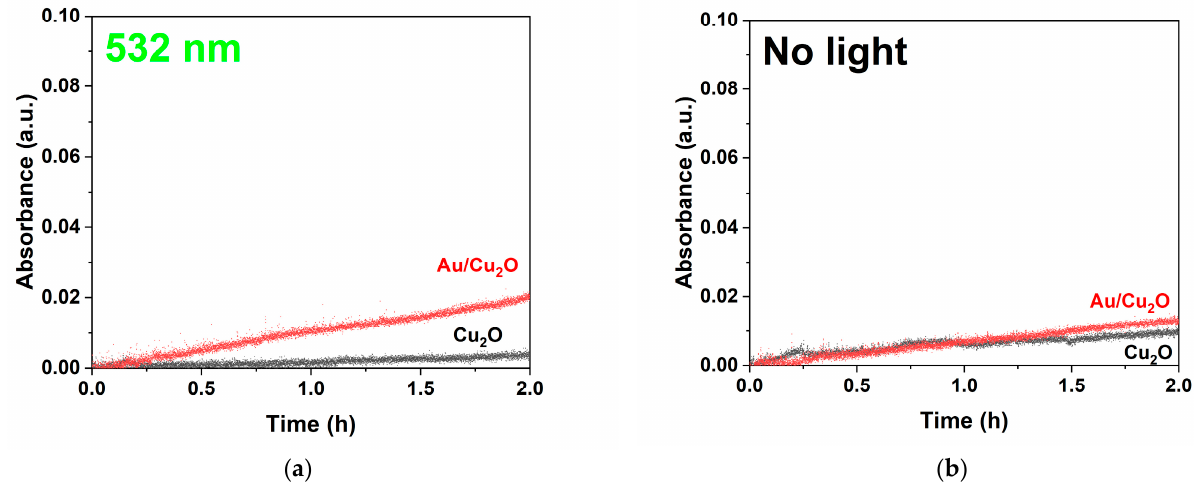
Figure 12. Azobenzene formation from aniline photo-oxidation: ( a ) under 532 nm laser excitation; ( b ) without laser excitation.